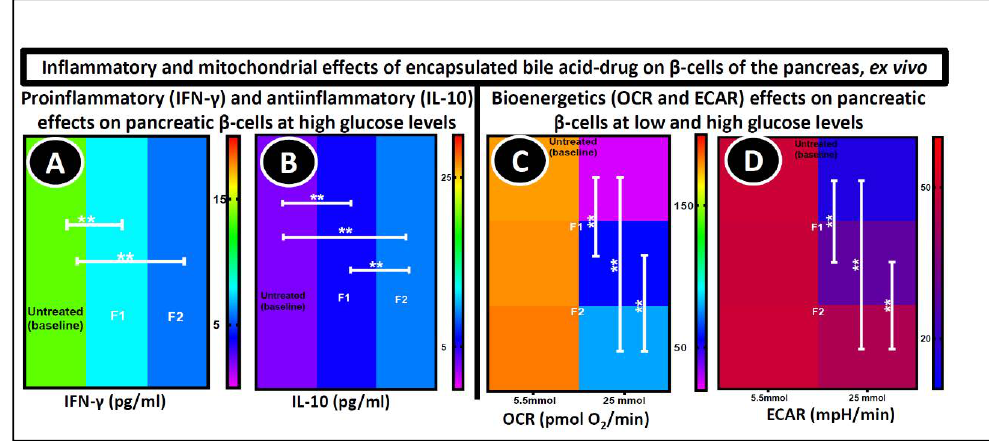
Figure 5. Cytokine production test ( A , B ) 48 h post-treatments and bioenergetics parameters ( C , D ) using the NIT-1 pancreatic β cell lines at two glucose concentrations: 5.5 mmol and 25 mmol. N = 3, mean ± SEM. F1: PB–LVSA microcapsules and F2: PB–ULCA–LVSA microcapsules. PB—probucol; LVSA—low-viscosity sodium alginate; ULCA—unconjugated lithocholic acid; IFN-γ—interferon gamma; IL-10—interleukin 10; OCR—oxygen consumption rate; ECAR—extracellular acidification rate * p < 0.01. ** p <